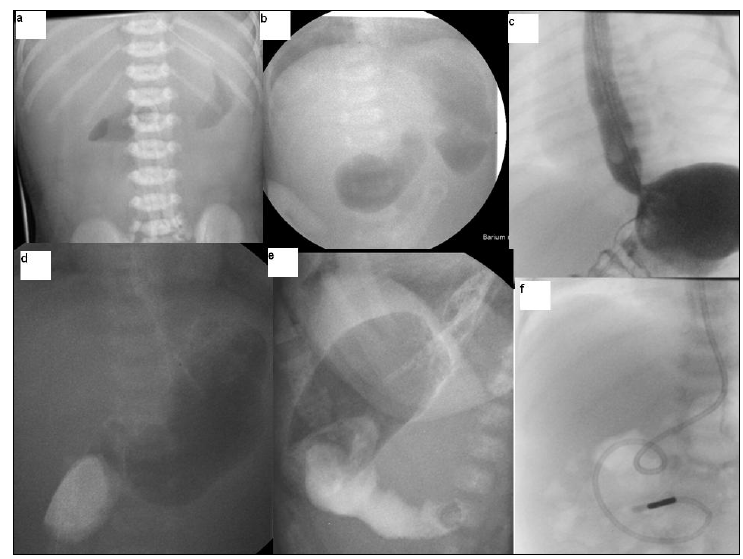
Figure 1: Plain and contrast imaging in the pre and post operative period.